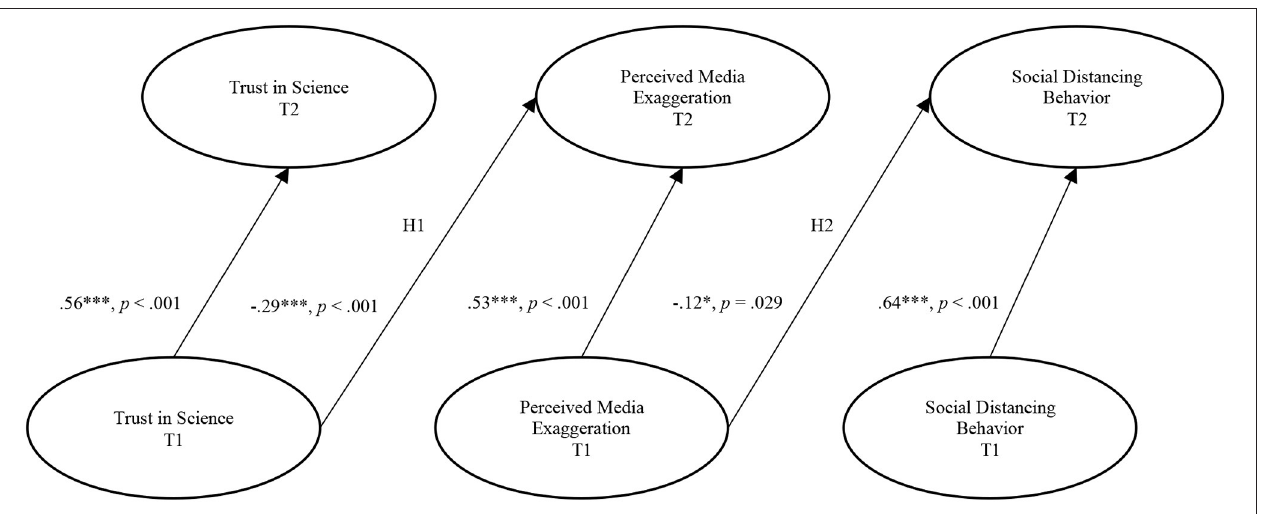
FIGURE 1 | Model considering the relationships between trust in science, perceived media exaggeration, and social distancing behavior. Values represent unstandardized coefficients. Ovals represent latent variables. Error terms, covariances, control variables, and measurement items are not shown. T1, Time 1; T2, Time 2. * p < 0.05, *** p <